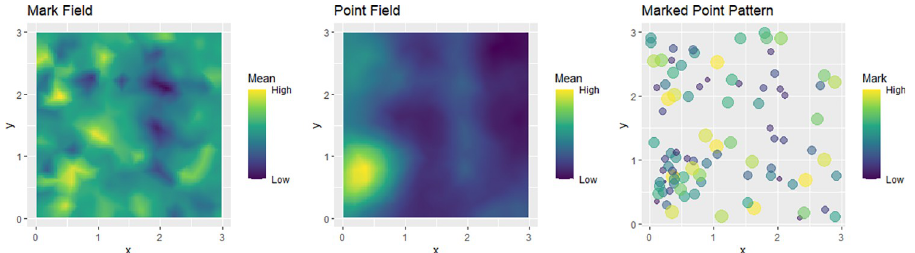
Fig 4. Multiplot showing the realization of the spatial fields alongside the marked point